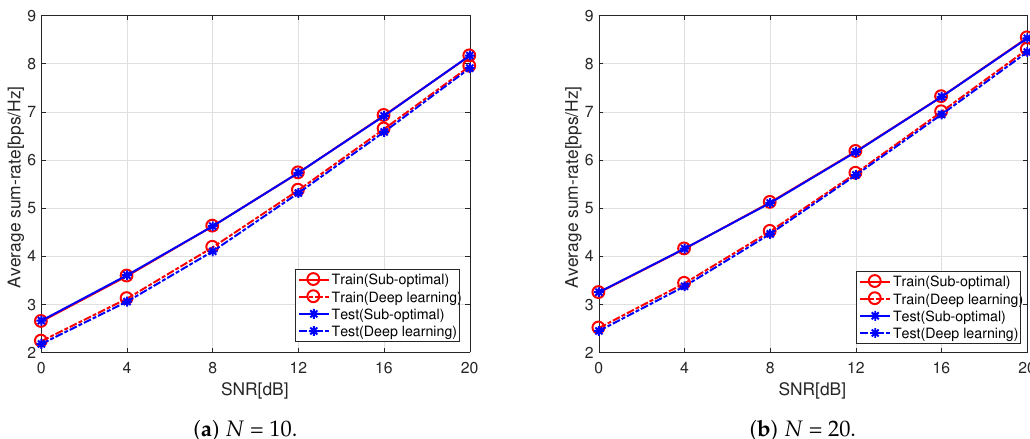
Figure 5. Average sum rates of the deep learning based scheme and sub-optimal scheme for various SNR values when N = 10 or